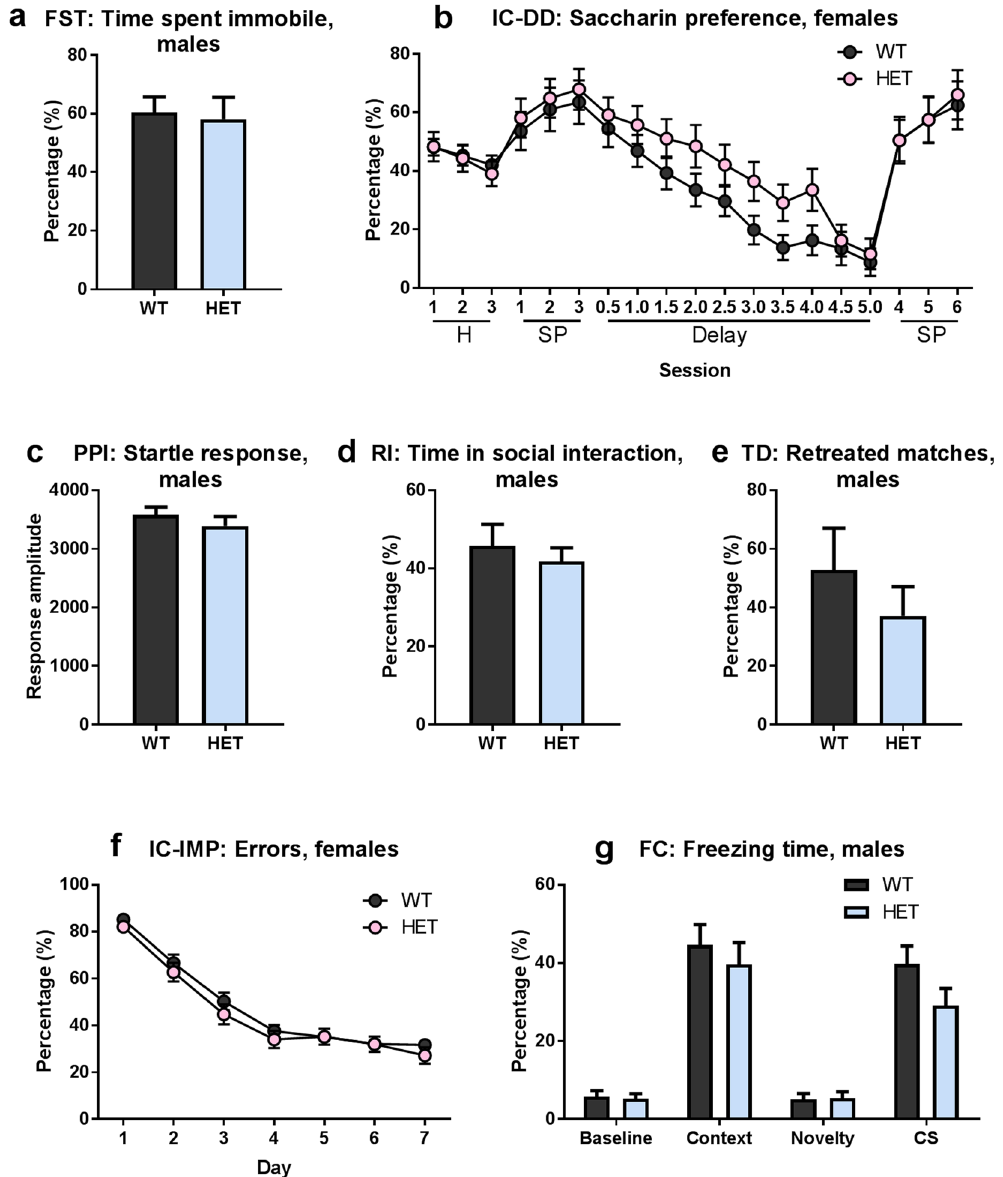
Figure 4. Neither neuropsychiatric disorder-related behaviors nor learning and memory are changed in Gdnf wt/ hyper mice ( a ) Percentage of time spent immobilized in the forced swim test; males. Student’s t-test, p = 0.81. ( b ) Percentage of licks at corners containing saccharin (saccharin preference) in the IntelliCage delay discounting task; females. Two-way repeated measures ANOVA, genotype effect p = 0.78 (habituation), p = 0.65 (saccharin preference), p = 0.14 (delay), p = 0.91 (preference II). ( c ) Average startle response amplitude over 10 trials; males. Student’s t-test p = 0.36. ( d ) Percentage of time spent in social interaction in the resident-intruder test; males. Student’s t-test, p = 0.54. ( e ) Percentage of lost matches in the tube dominance test; males. Student’s t-test, p = 0.37. ( f ) Percentage of premature responses in the motor impulsivity (IMP) task; females. Two-way repeated measures ANOVA, genotype effect p = 0.35. ( g ) Percentage of time spent freezing in the fear conditioning test; males. Multiple Student’s t-tests with Holm-Sidak correction, p = 0.99 (Baseline), p = 0.71 (Context), p = 0.99 (Novelty), p = 0.15 (Conditioned Stimulus). ( a , d ) N = 10 Gdnf wt/wt , 10 Gdnf wt/hyper . ( b ) N = 19 Gdnf wt/wt , 17 Gdnf wt/hyper . ( c ) N = 34 Gdnf wt/wt , 31 Gdnf wt/hyper . ( e ) N = 8 Gdnf wt/wt , 10 Gdnf wt/hyper . ( f ) N = 20 Gdnf wt/wt , 19 Gdnf wt/hyper . ( g ) N = 32 Gdnf wt/wt , 30 Gdnf wt/hyper . Abbreviations: FC, fear conditioning; FST, forced swimming test; H, habituation; IC-DD, delay discounting task; IC-IMP, motor impulsivity task; PPI, prepulse inhibition; RI, resident-intruder test; SP, saccharin preference; TD, tube dominance test. Data is presented as mean ±